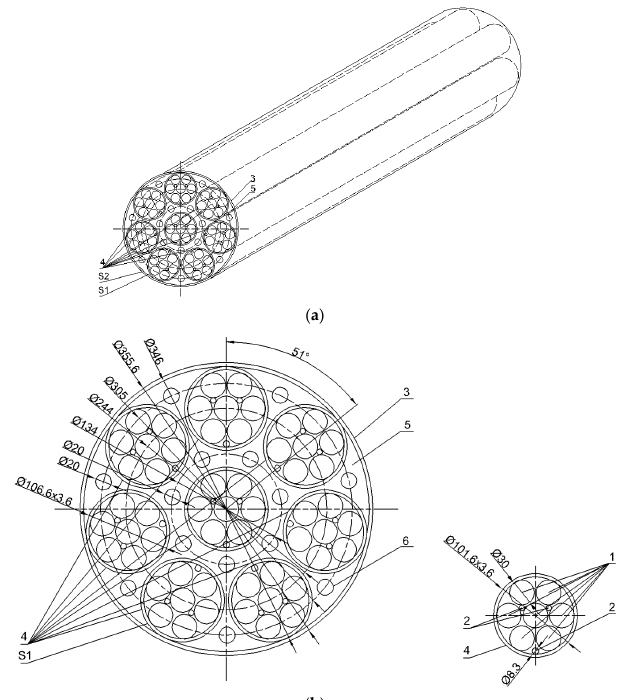
Figure 3. Ceramic heat accumulator: ( a ) view of the accumulator packing; ( b ) outer shell and regenerator components. 1—ceramic cylinders, 2—resistance electric heaters, 3—accumulator outer casing, 4—steel tubes (inside of which there are seven rows of ceramic cylinders), 5—a bottom with openings through which air flowed into the inter-tube space, 6—the air intake opening to the inter-tube space. Energies 2022 , 15 , x FOR PEER REVIEW